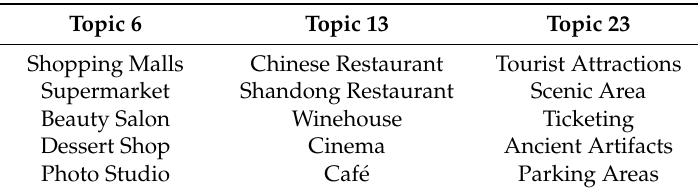
Table 2. Distributions of several land cover topics.